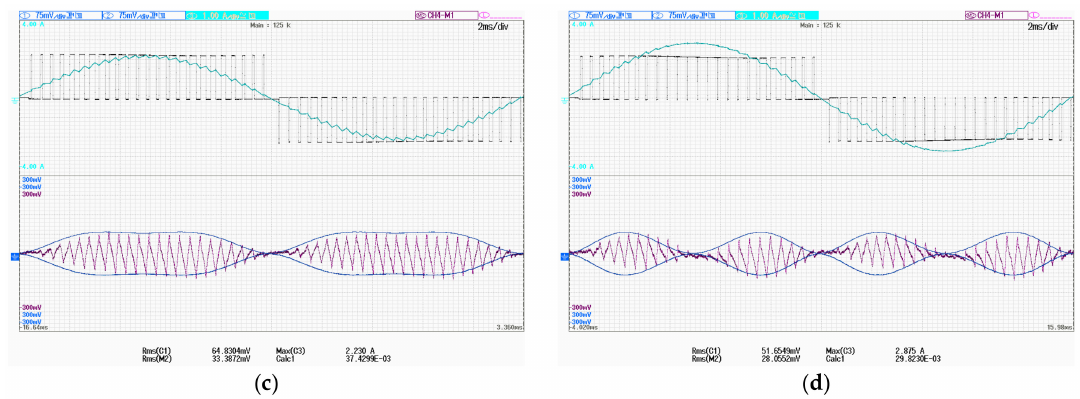
Figure 13. Experimental results for ϕ = 0 ◦ : upper half, output voltage and current; lower half, analytically calculated envelope and measured DC voltage switching ripple. ( a ) m = 0.25; ( b ) m = 0.50; ( c ) m = 0.75; ( d ) m = 1.